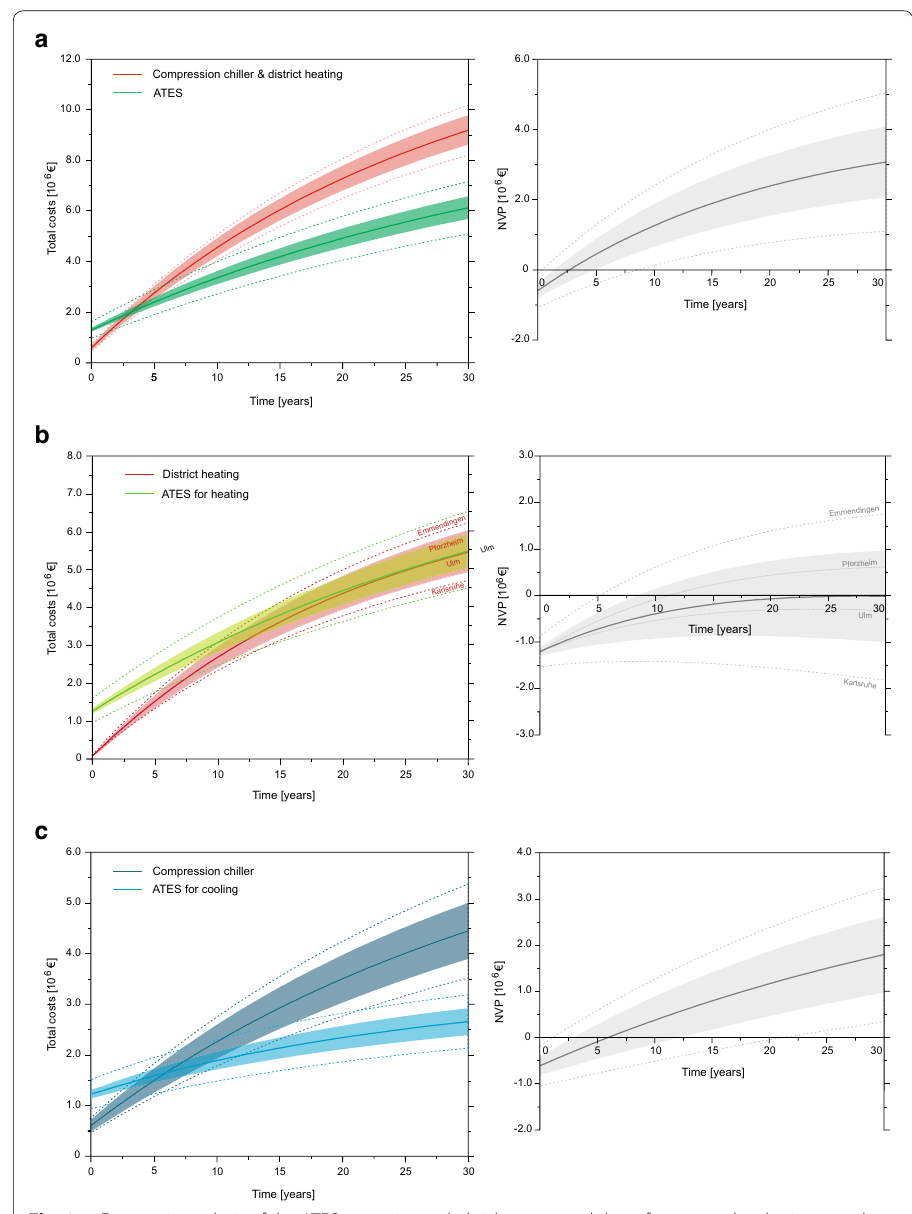
Fig. 8 a Economic analysis of the ATES operating as hybrid system and the reference technologies over the observation period of 30 years divided into total costs and the NPV of the ATES system; b comparison of the total costs for the ATES system only for the heating supply of the building compared with district heating; c specifically compares the total costs for the direct cooling supply by the ATES system and the compression